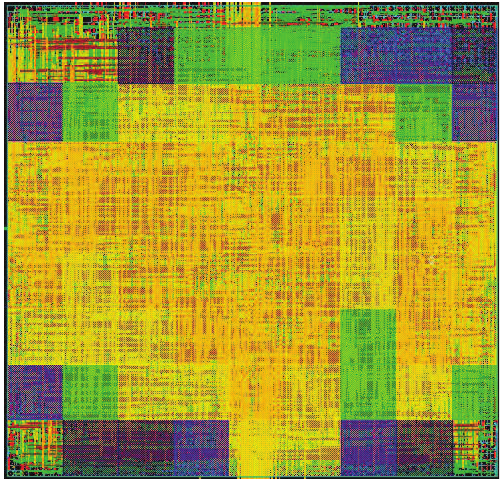
Figure 8. A 180 nm CMOS based physical design of the proposed 45-bit GF multiplier with multiple error correction